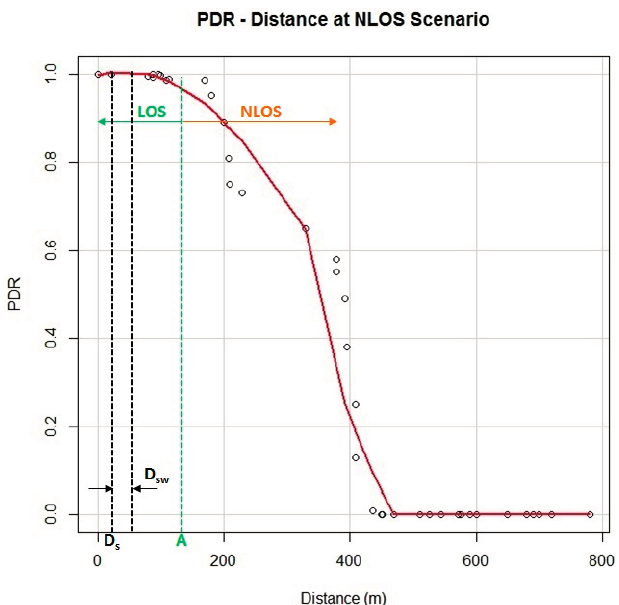
Figure 14. PDR measurements